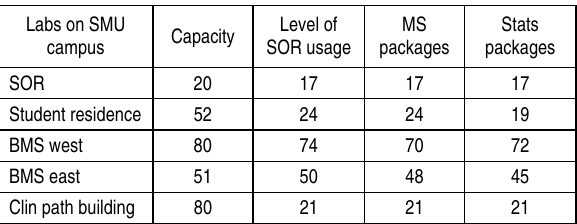
Table 2. Laboratory capacity for SOR business